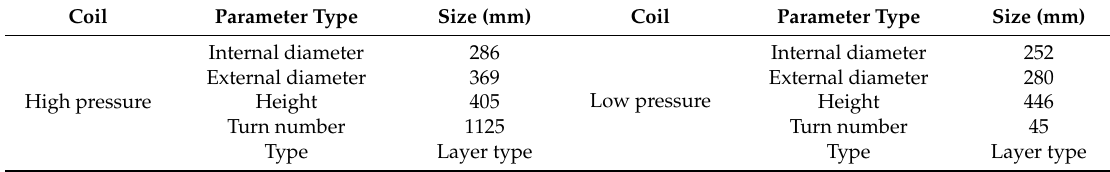
Table 3. Main parameters of the transformer core structure.